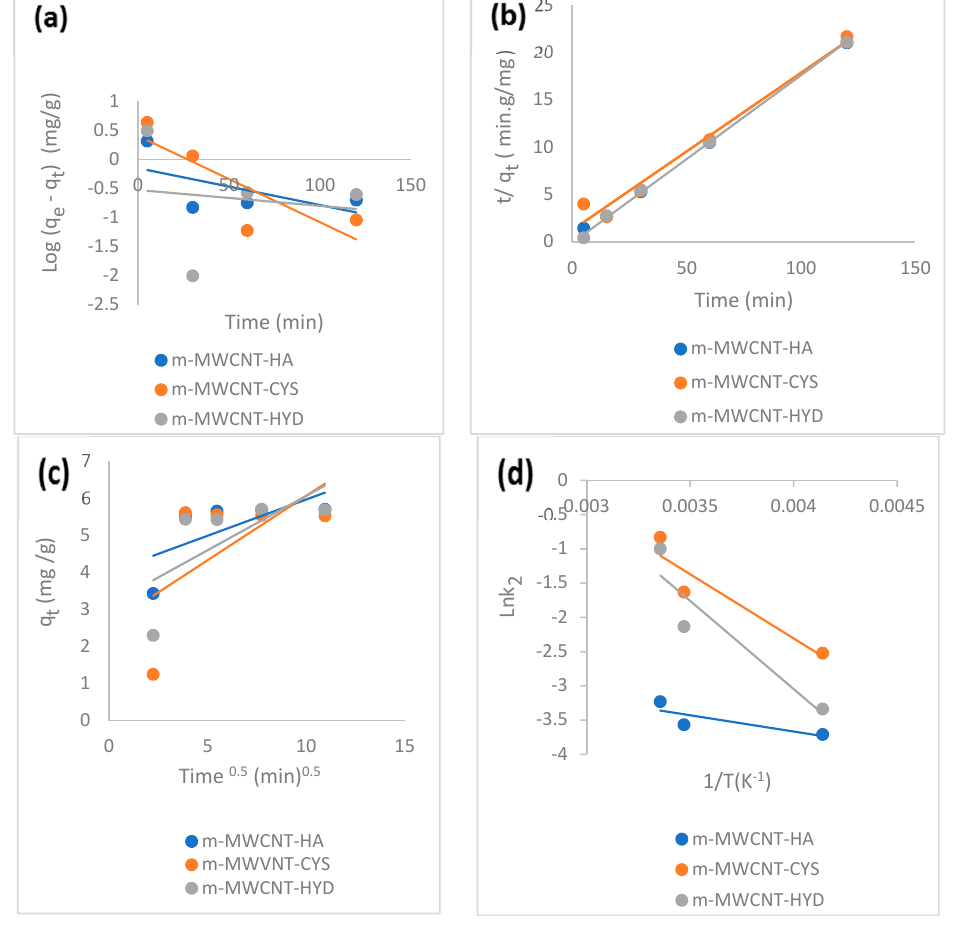
Figure 11. ( a ) The pseudo-first-order kinetic plot. ( b ) The pseudo-second-order kinetic plot. ( c ) Intra-particle diffusion kinetic model. ( d ) Arrhenius plot for Ibu adsorption on m-MWCNT–HA, m-MWCNT–CYS, and m-MWCNT–HYD. Table 3. Parameters for Ibu adsorption of kinetic models of pseudo-first-order, pseudo-second-order and intraparticle diffusion on m-MWCNT–HA, m-MWCNT–CYS and m-MWCNT–HYD.